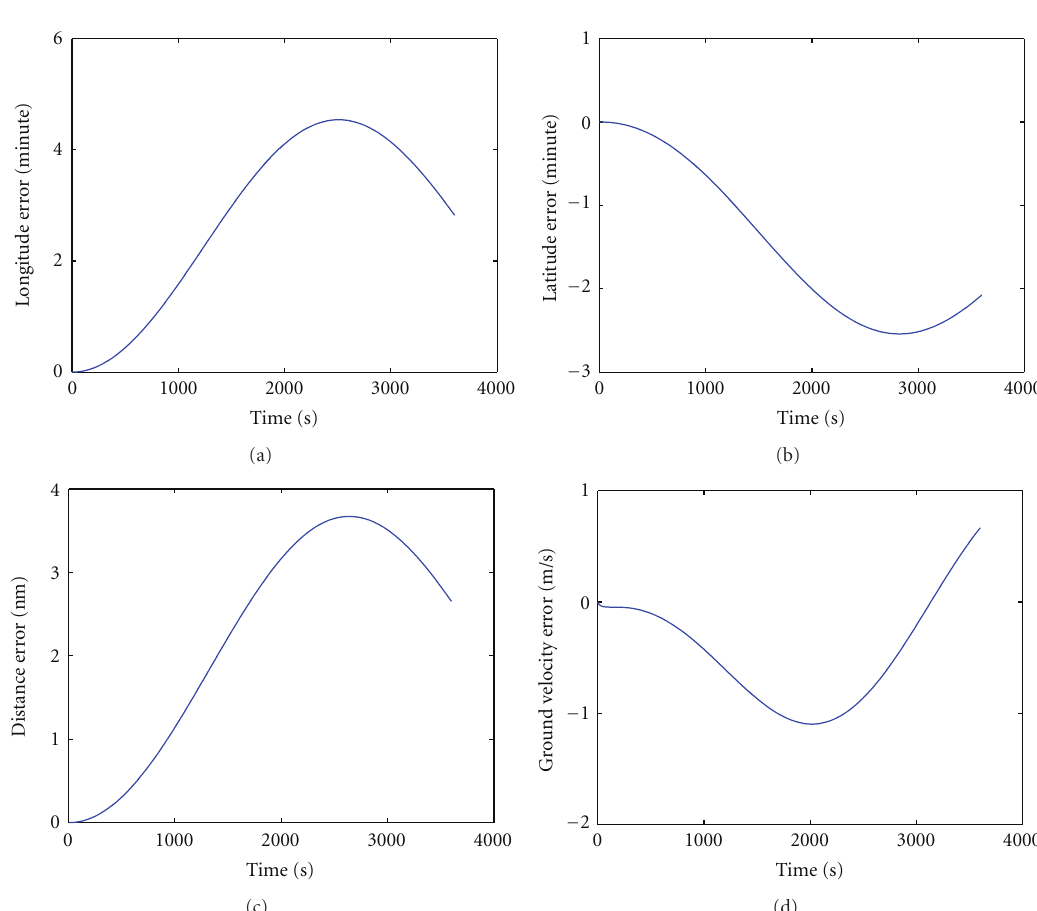
Figure 14: Position and velocity error of straight line